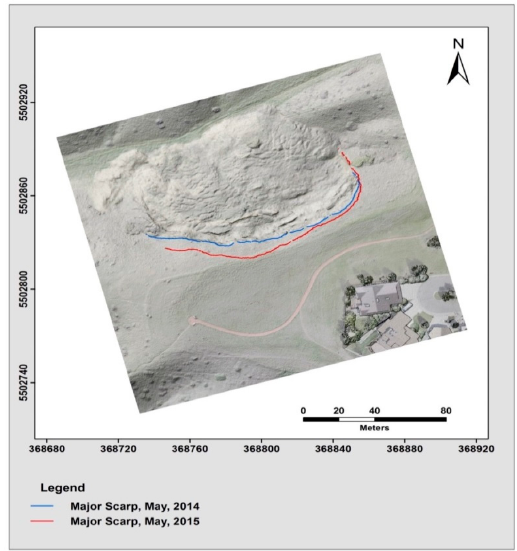
Figure 18. Illustrates the extracted landslide scarp feature results for an epoch from 2014 (blue) and an epoch captured in 2015 (red) of the Lethbridge, Kings Park landslide area.